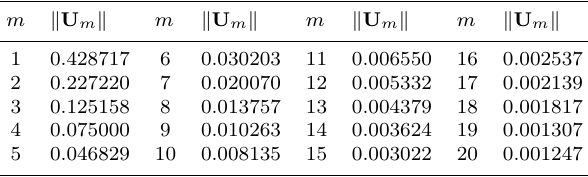
Values of the norm of functions U m for the optimal value of the convergence control parameter m (cid:107) U m